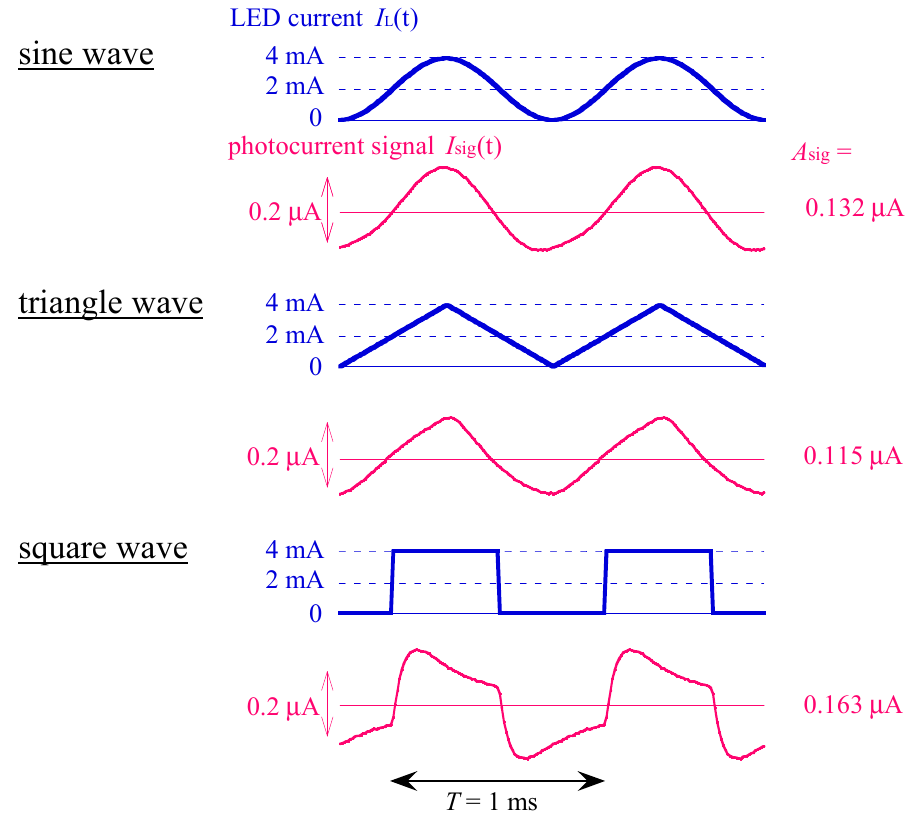
Figure 2. Waveforms of photocurrent signal ( I sig ( t ) ) (plotted in red) in response to different wave- forms (sine, triangle, and square) of I L ( t ) (plotted in blue) with the same frequency (1 kHz) and the same average LED current (2 mA). The values of the amplitude of fundamental frequency ( A sig ) are also shown. All the waveforms shown in this figure are averages from over 100 cycles recorded.